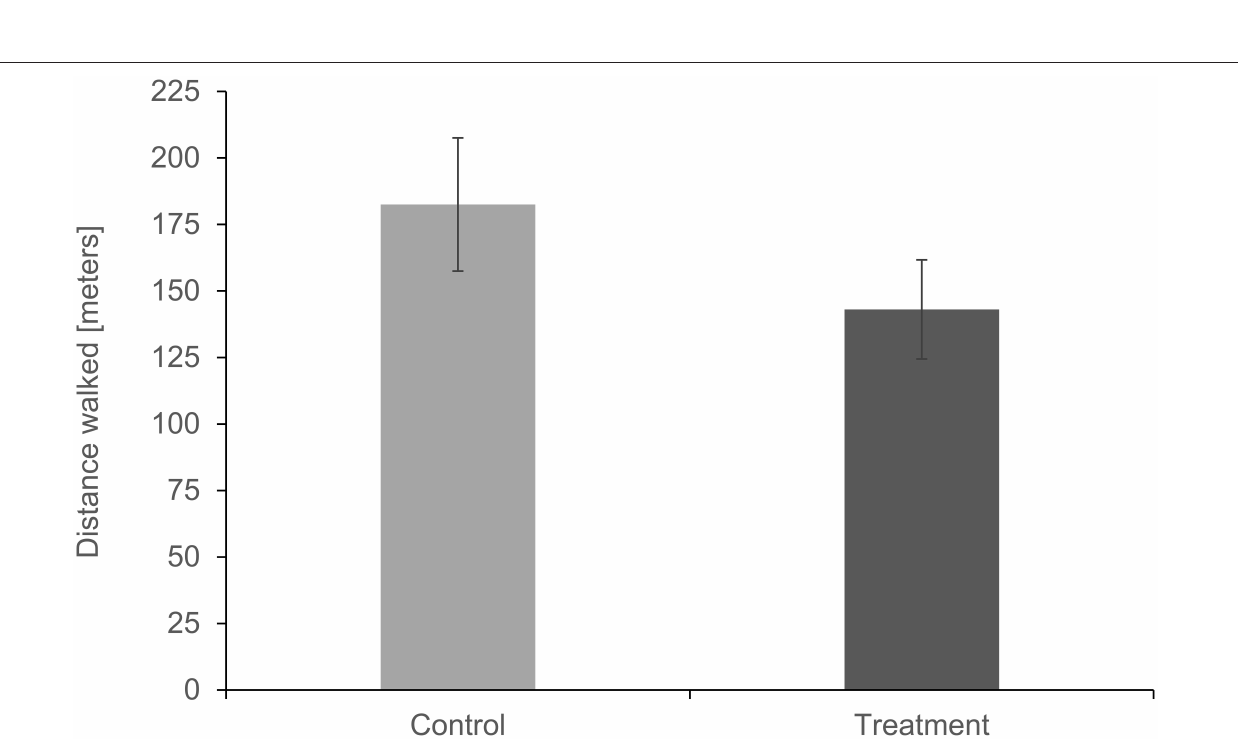
FIGURE 7 | Distance walked by condition. Error bars represent 95% CI.